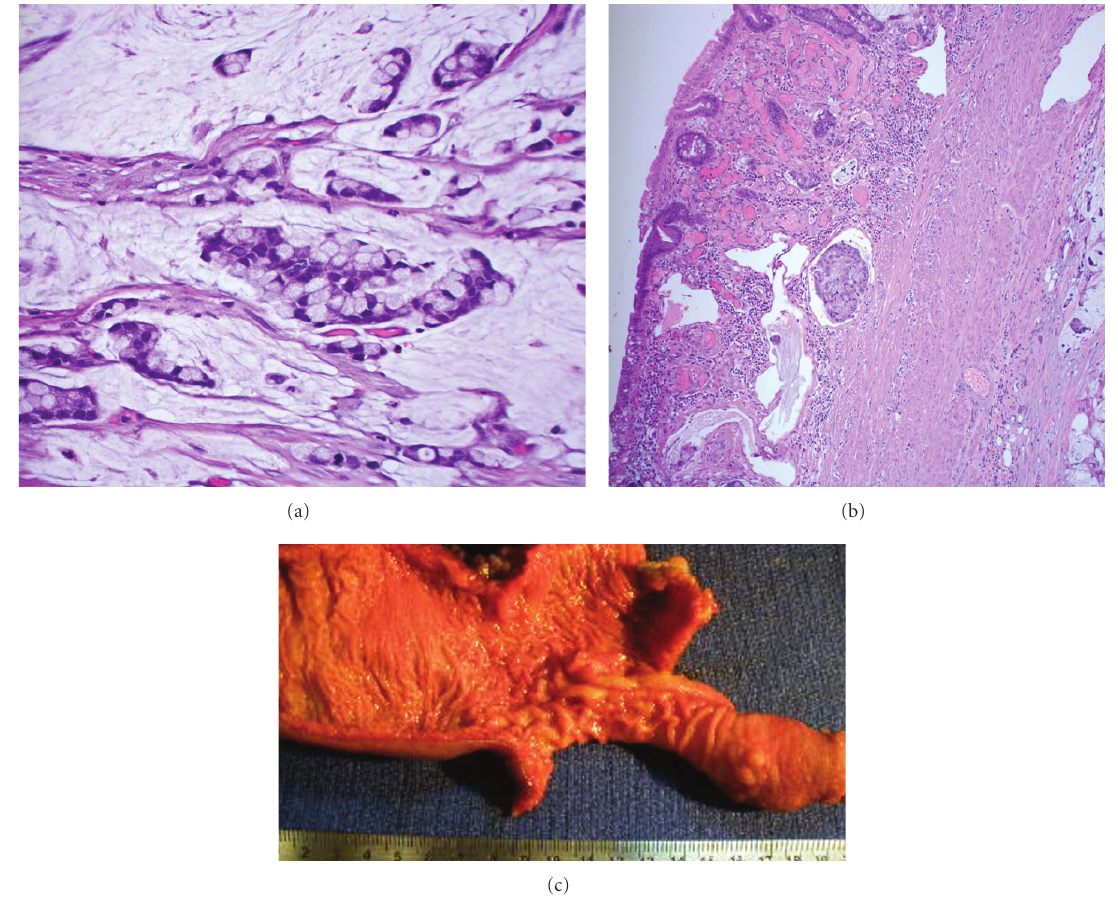
Figure 3: Histopathology of colon biopsy at high power field reveals malignant cells (a). Histopathology of ileum biopsy reveals metastatic malignancy (b). Gross histology revealed a metastatic ileal deposit as a lead point of intussusception